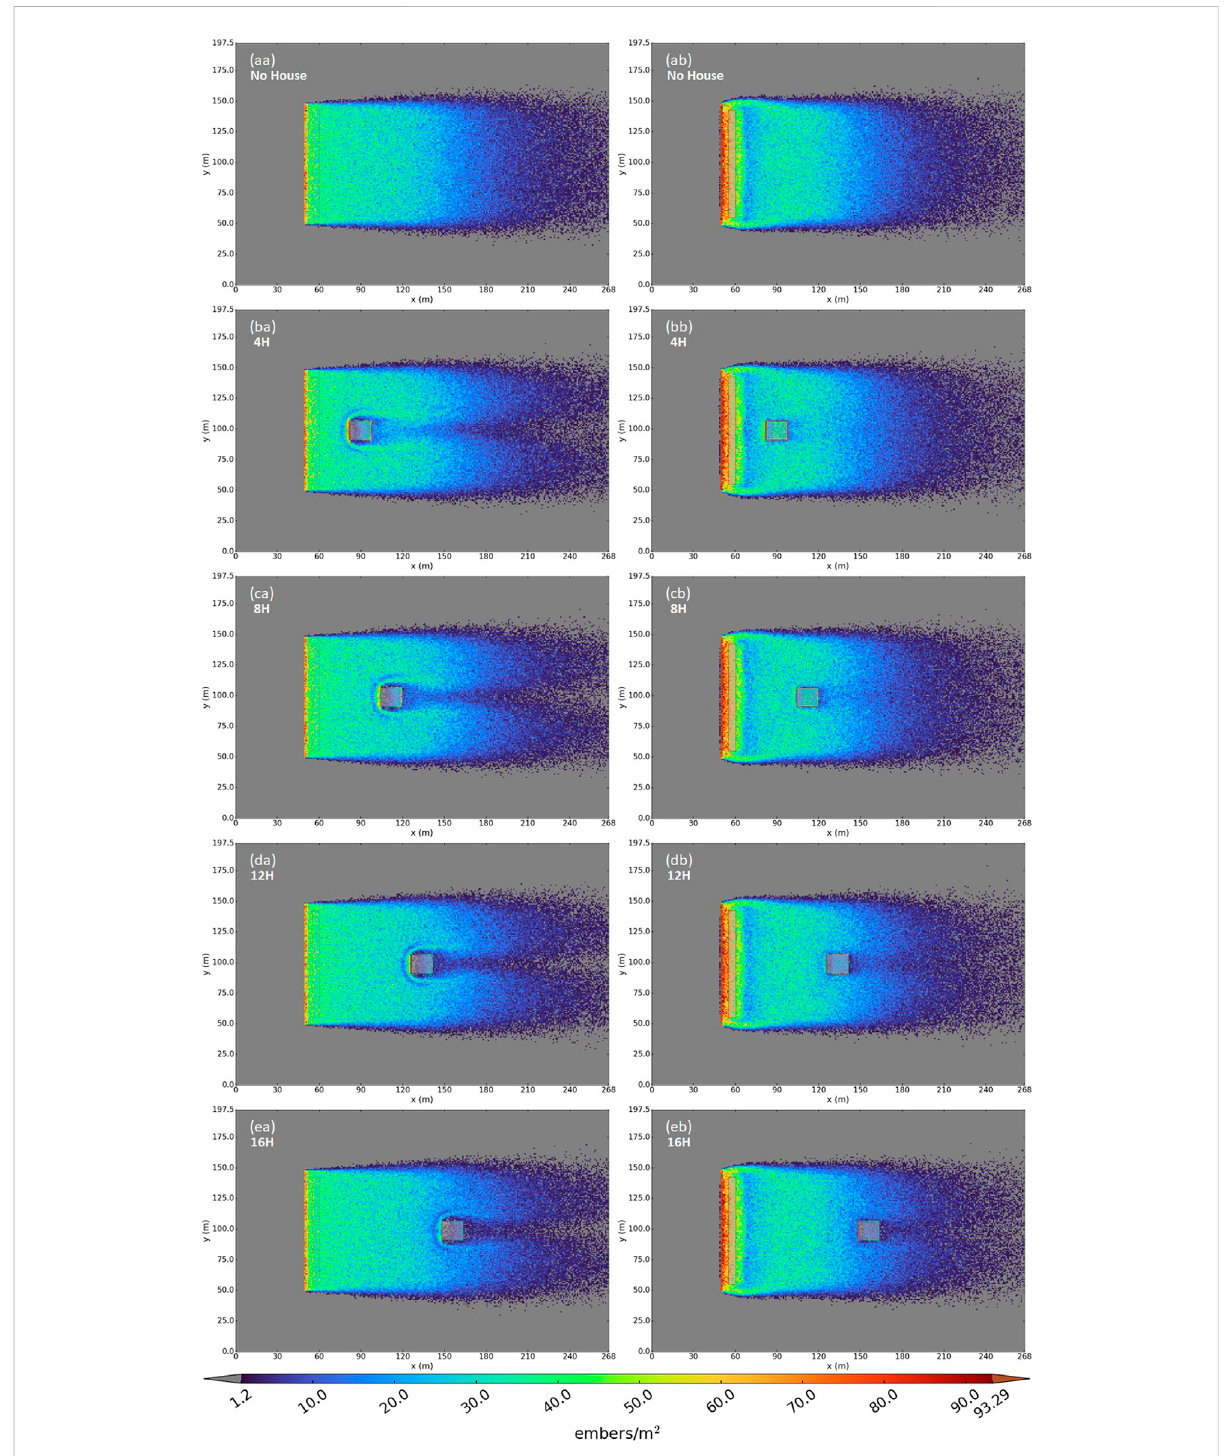
FIGURE 6 Firebrand deposition for the base case experiments. The house is located at various distances downwind with and without the fence present in the fl ow. The fi rst letter (A – E) represents the distance downwind in the fl ow. The second letter represents the (A) absence or (B) presence of the fence. The colors represent the deposition per unit